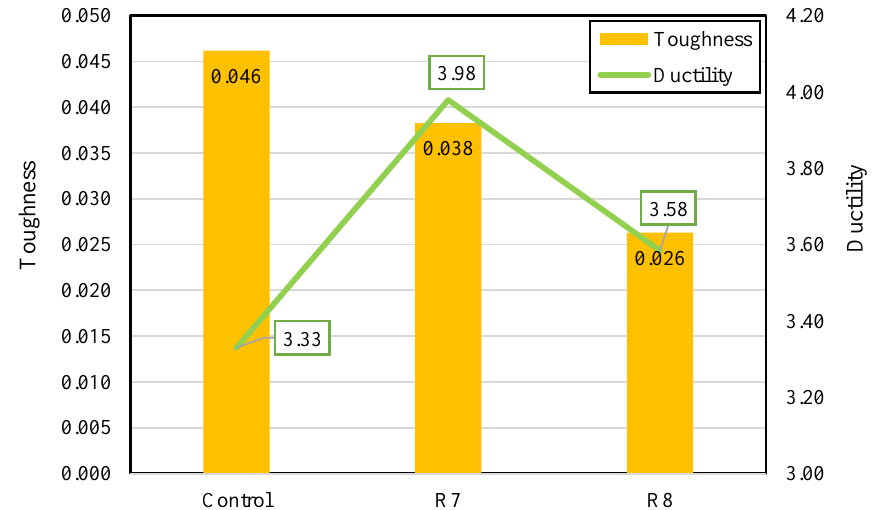
Figure 18. The calculated toughness area under stress-strain curve.